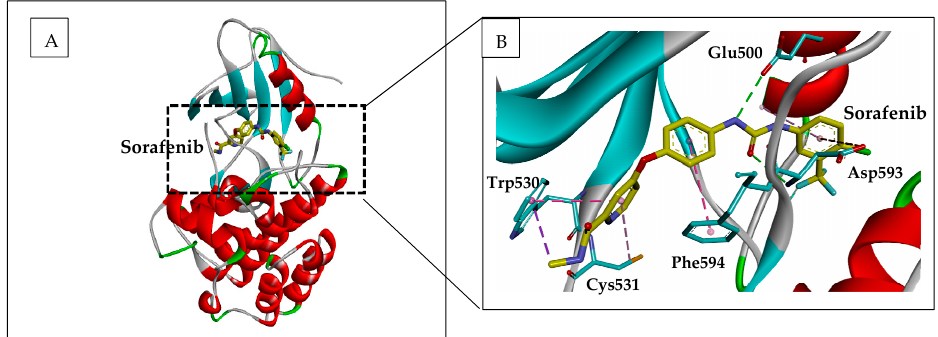
Figure 3. Representation of Sorafenib in complex with B-Raf. ( A ) Ribbon representation of b-Raf in complex with Sorafenib (yellow sticks). The 3-D structure used (pdb code 1UWH) was uploaded Figure 3 . Representation of Sorafenib in complex with B-Raf. A, Ribbon representation of b-Raf in complex with Sorafenib from the protein data bank (https://www.rcsb.org/structure/1UWH). ( B ) zoom from A showing (yellow sticks). The 3-D structure used (pdb code 1UWH) was uploaded from the protein data bank interacting residues (blue sticks) with Sorafenib in the active site of b-Raf. Figure was constructed using the BIOVIA Discovery Studio software (BIOVIA, Dassault Systèmes, [BIOVIA Discovery Studio], [v17.2.0.16349], San Diego: Dassault Systèmes,